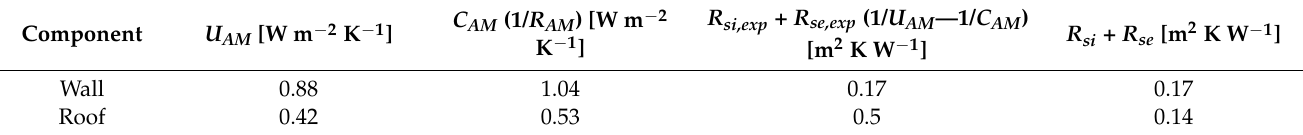
Table 2. Experimental values of transmittance, conductance, and surface resistances.